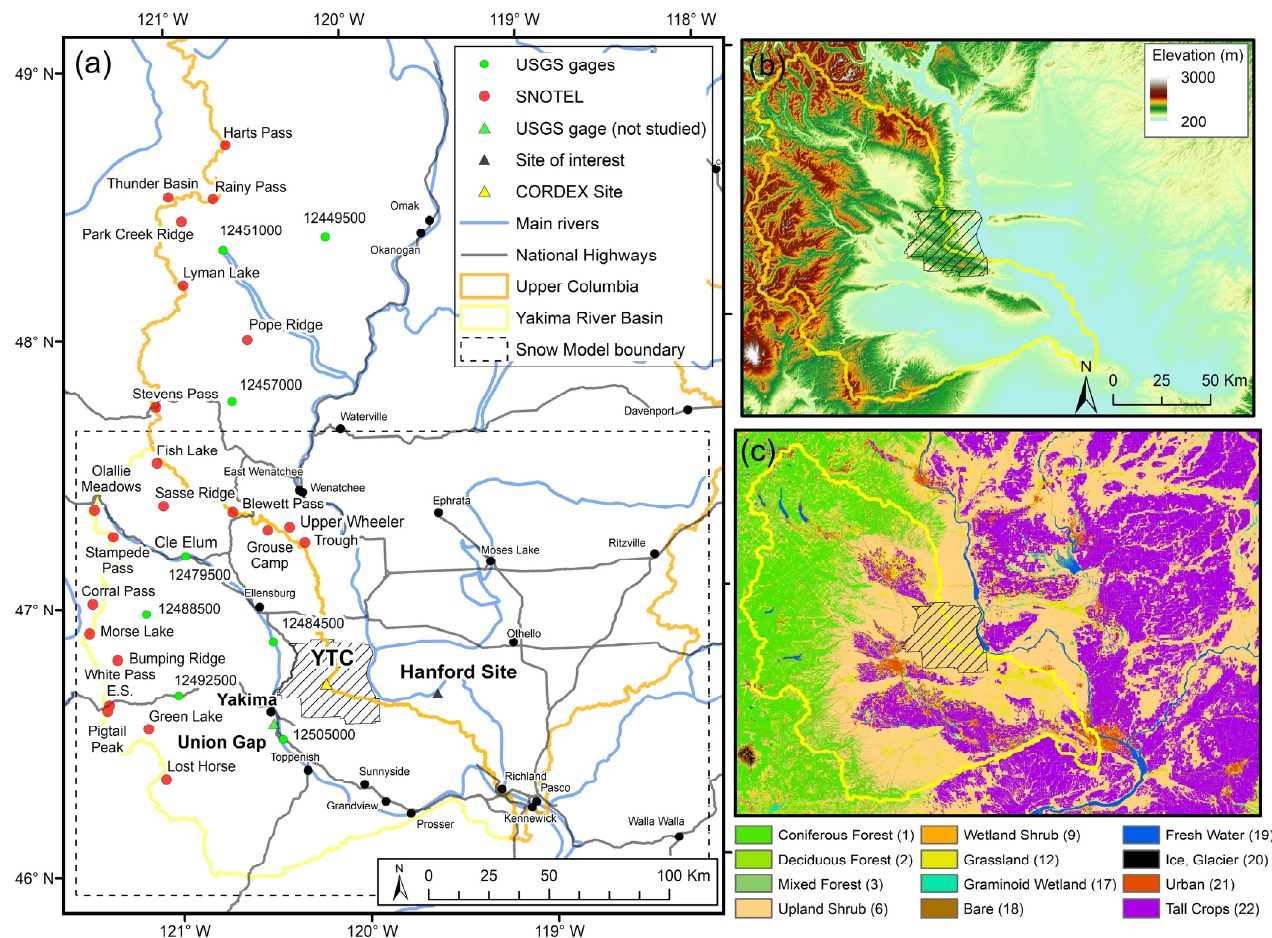
Figure 1. ( a ) Map of the study area and river basins, showing the YTC, selected cities including the town of Yakima (black dots), the snow modeling boundary (dashed line), hydrological unit code (HUC) 8 boundaries for the Yakima and Upper Columbia river basins, USGS gages (green solid dots, see Table S2), and SNOTEL stations (red solid dots, see Table S1). ( b ) Elevation and ( c ) land cover from 2013 National Land Cover Data [42] for the snow modeling area.